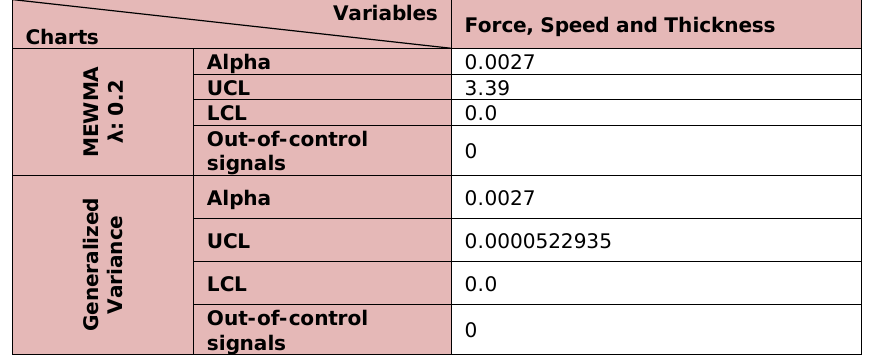
Table 11. “MEWMA and generalized variance charts parameters for regressed data”.